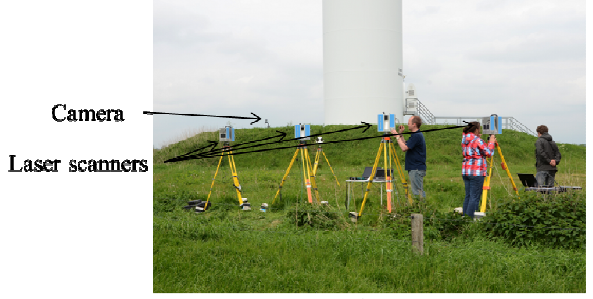
Figure 4. Measuring arrangement of the camera and laser scanners